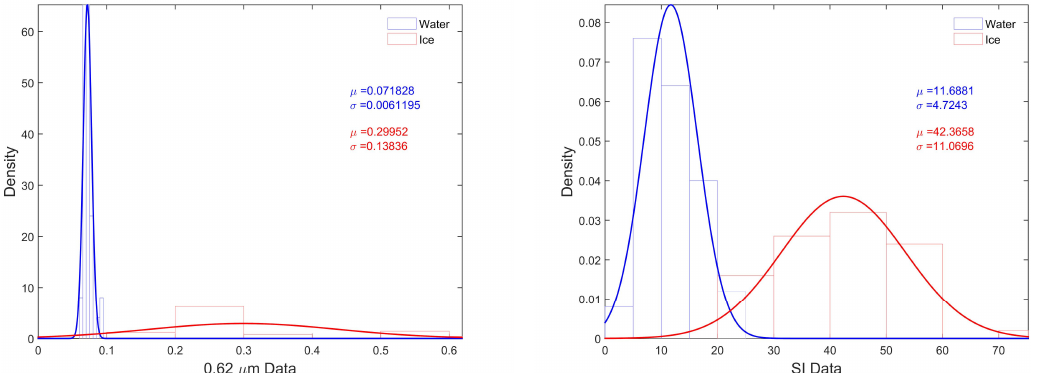
Figure 8. Probability distribution functions of water (blue) and ice (red) at 1830 UTC on 28 February 2015: ( left ) distribution of reflectance; ( right ) distribution of snow index.